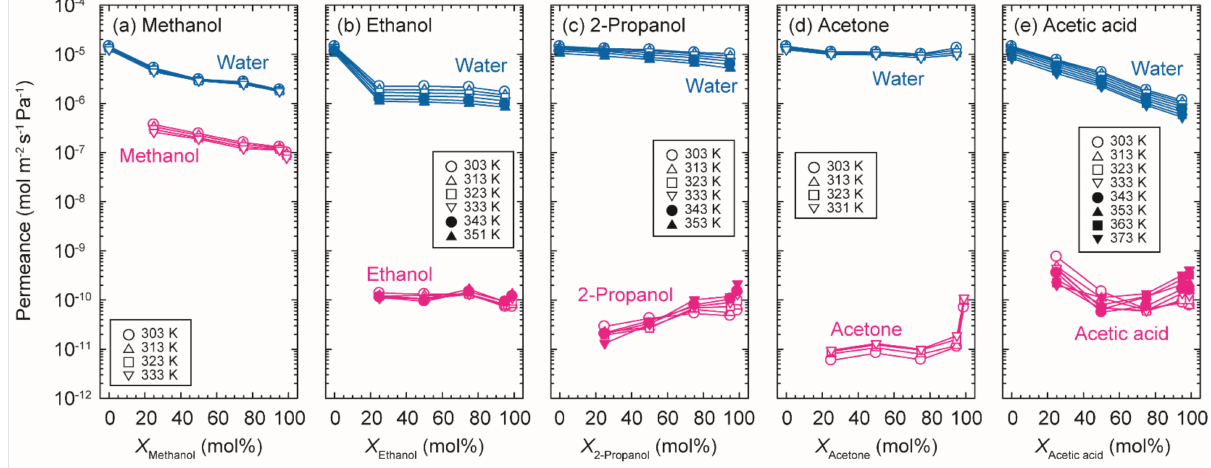
Figure 7. Influences of the concentration of organic solvents in the feed solutions on the permeances of water and organic solvents at 303–373